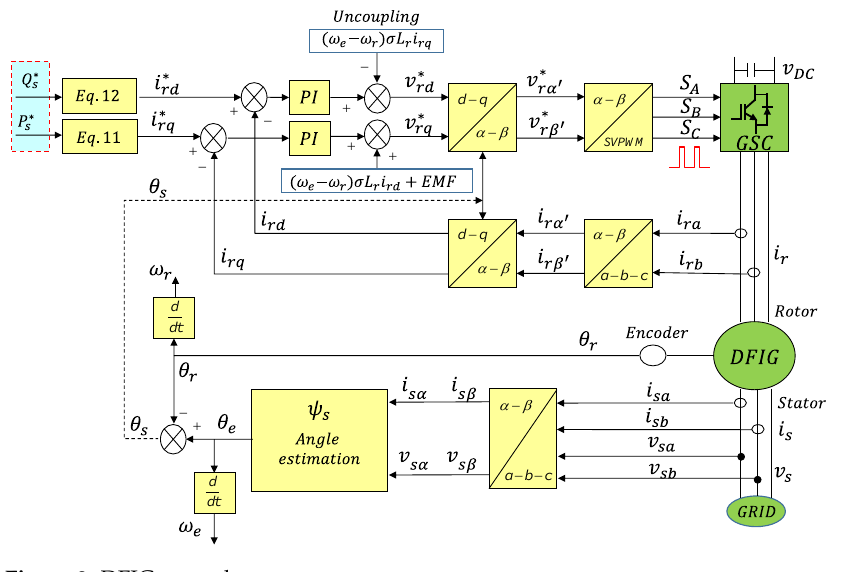
Figure 2. DFIG control structure.